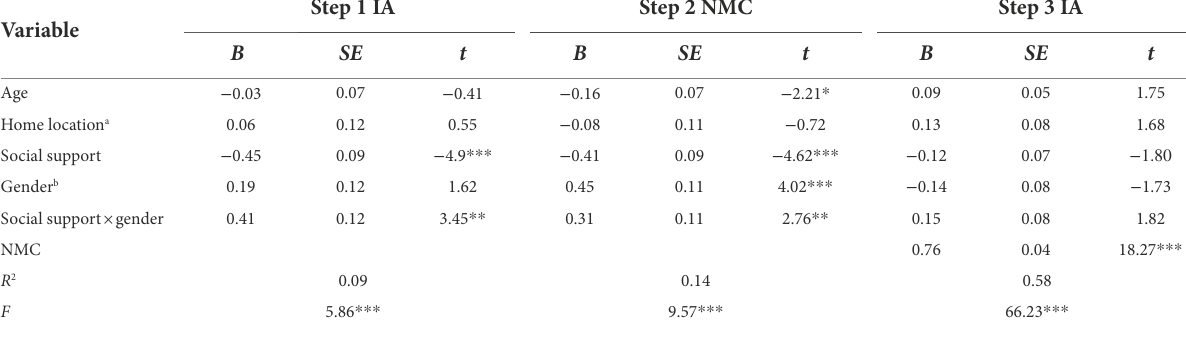
TABLE 2 A regression test of the mediated moderating effect ( n = 322).